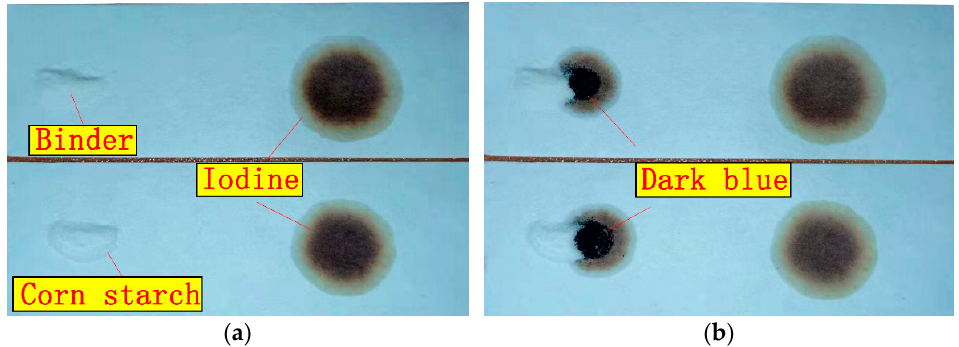
Figure 5. Experiment of binder and corn starch with dilute iodine solution. ( a ) Brilliant white of binder and corn starch; ( b ) iodine–binder and iodine ‐ starch staining.